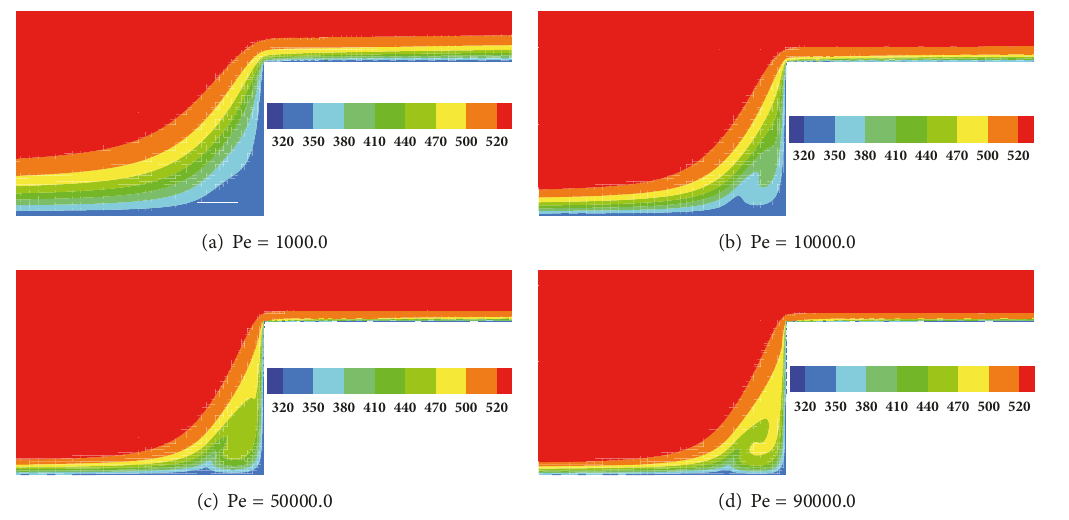
Figure 4: Temperature distributions with increasing Pe